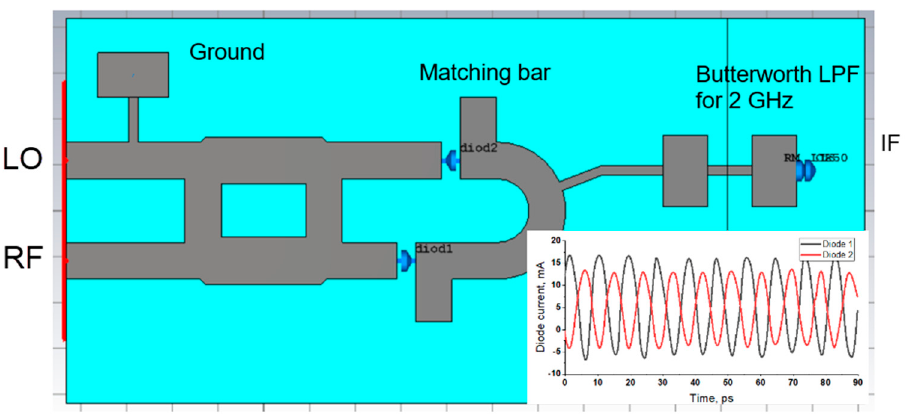
Figure 5. W-band mixer of the RF and LO signals with close frequencies around 110 GHz. The picture shows a PCB layout of the mixer with the IF, ground, and output port. Also shown are the diode currents induced by the 110 GHz LO signal, which are perfectly in the anti-phase. The IF output is attached to the area of zero electric field, so that it does not pick up the high frequency radiation.